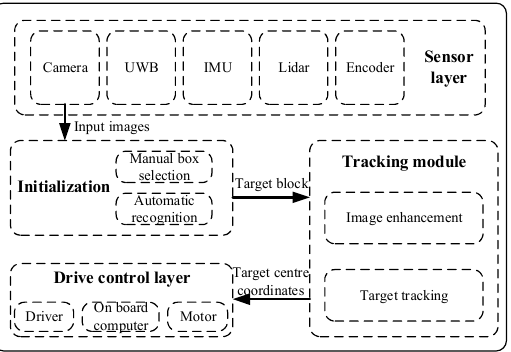
Figure 4. Hardware and software framework of vision tracking system for coal mine drilling robot.